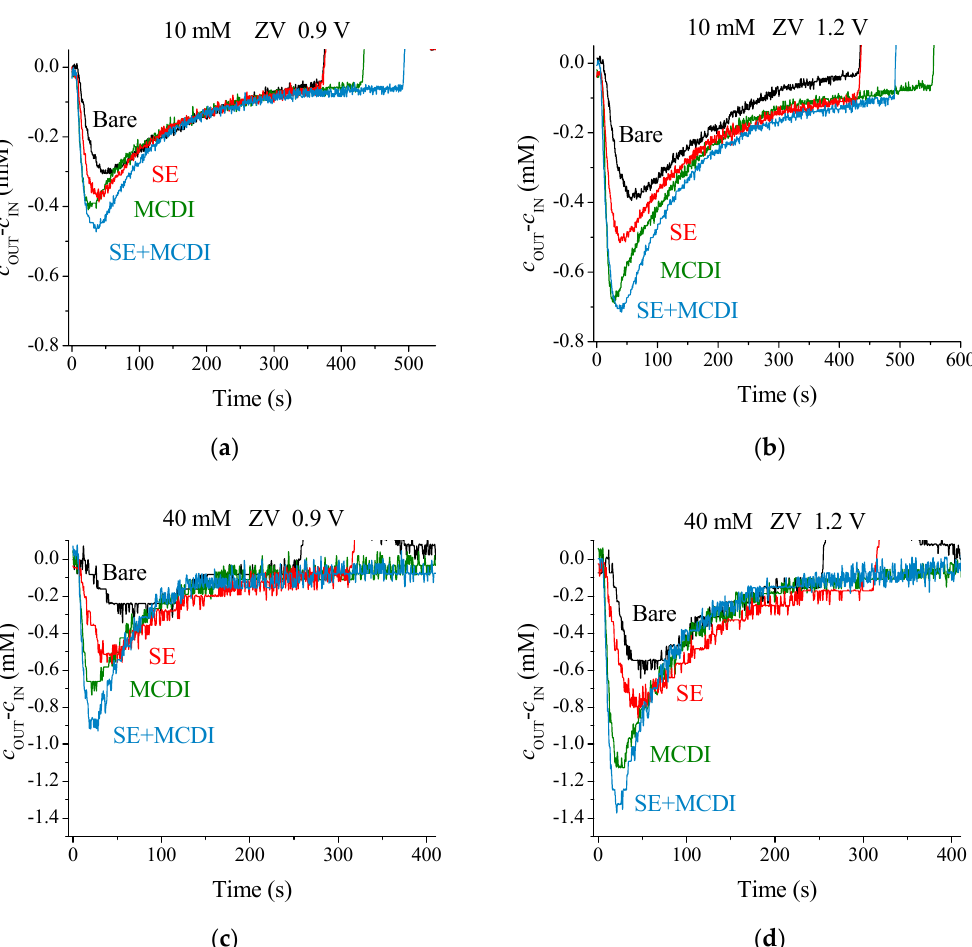
Figure 4. Adsorption stage for 10 and 40 mM NaCl at 0.9 and 1.2 V with ZV desorption using different techniques: ( a ) 10 mM NaCl, ZV 0.9 V; ( b ) 10 mM NaCl, ZV 1.2 V; ( c ) 40 mM NaCl, ZV 0.9 V; ( d ) 40 mM NaCl, ZV 1.2 V.